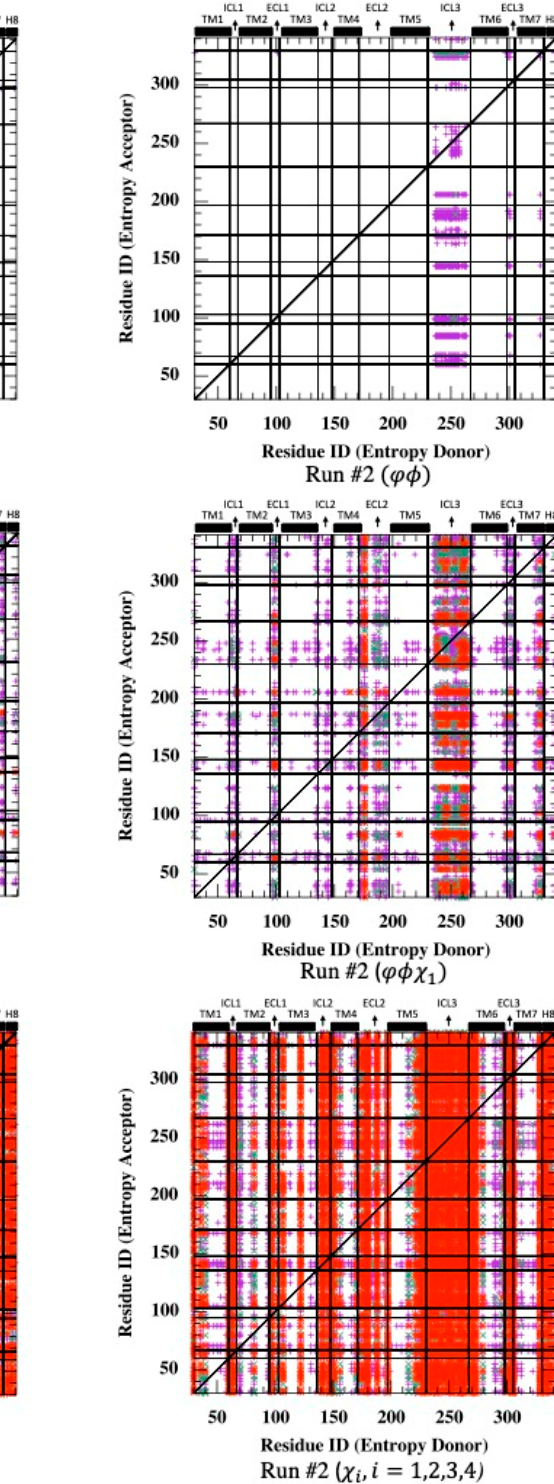
Figure 6. Net transfer entropy from residue i to residue j (see Equation (8)) for two independent MD runs using ( a ) backbone torsion angles, ( φ , ψ ) , ( b ) backbone torsion angles, ( φ , ψ ) and the first side-chain torsion angle ( χ 1 ) and ( c ) all possible side-chain torsion angles χ k , k = 1,2,3,4. Color code for ( a , b ): no display for (cid:104) netTE (cid:105) ≤ 4; magenta for 4 < (cid:104) netTE (cid:105) ≤ 8, green for 8 < (cid:104) netTE (cid:105) ≤ 12 and red for 12 > (cid:104) netTE (cid:105)